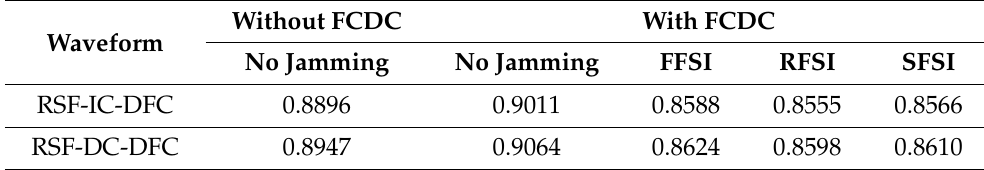
Table 4. Comparison of the image quality in